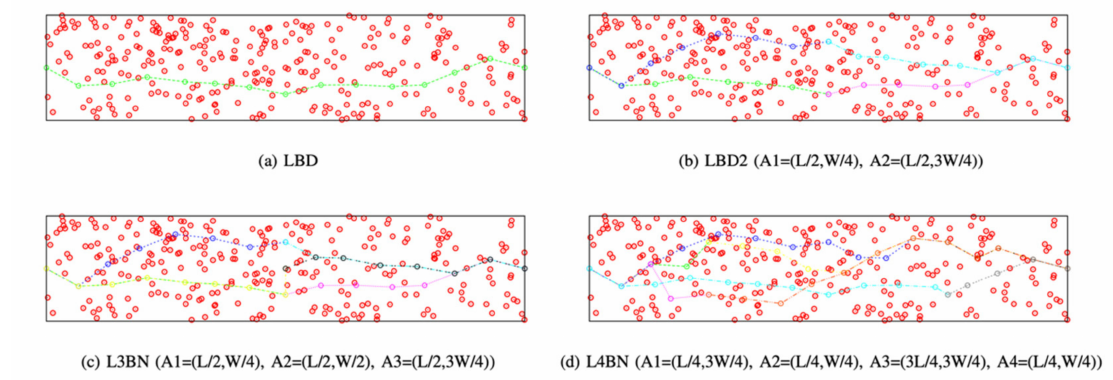
Figure 8. Visual examples of the discovered backbones for LBD, LBD2, LBD3, and LBD4, with L = 2500, W = 500, range = 200, and N = 300. ( a ) LBD ( b ) LBD2 (A1 = (L/2,W/4), A2 = (L/2,3W/4)) ( c ) LBN3 (A1 = (L/2,W/4), A2 = (L/2,W/2), A3 = (L/2,3W/4)) ( d ) LBN4 (A1 = (L/4,3W/4), A2 = (L/4,W/4), A3 = (3L/4,3W/4), A4 =